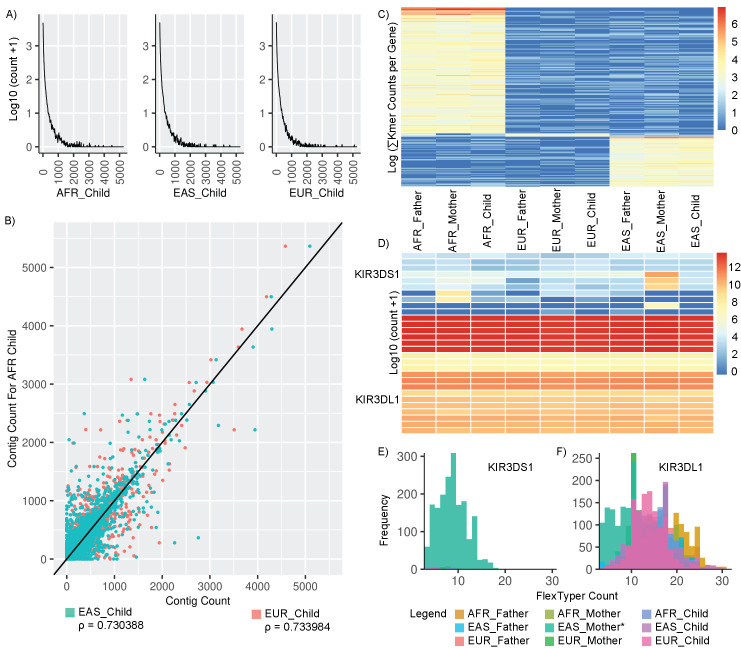
Explorative uses of FlexTyper.Two examples of the creative uses of FlexTyper within challenging regions. A) Density plots of counts for the African contigs for the children from the three populations (left to right AFR, EAS, EUR). B) Scatterplot comparing the African contig counts for the AFR child against the EUR child (pink) and the EAS child (teal). C) Heatmap in log-scale for population-specific contigs, clustered by sample similarity (columns) and contig count similarity (rows). D) Heatmap showing the log10 transform of the sum of k-mer counts per gene, with genes as rows, and samples as columns. The two alleles, KIR3DS1 and KIR3DL1 are labeled as rows on the left side. E) Overlayed histograms for the 9 samples, showing the frequency of the FlexTyper k-mer count for the KIR3DS1 allele. F) Overlayed histogram showing the frequency of the FlexTyper k-mer count for the KIR3DL1 allele.